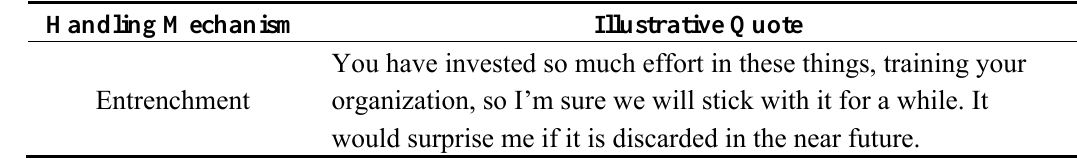
Table 9. Replication of the